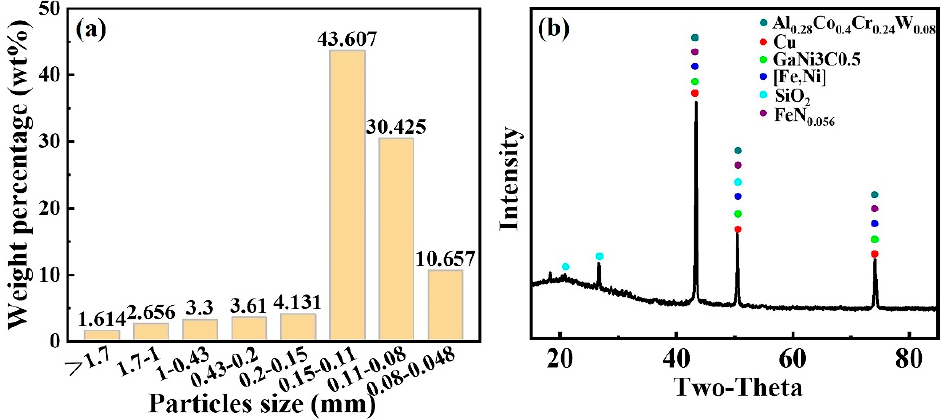
Figure 1. ( a ) The particle size distribution of WPCBs, ( b ) XRD analysis of WPCBs particles. Table 1. The compositions of metals in WPCBs particles.